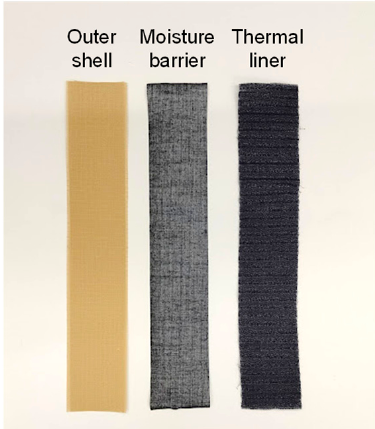
Figure 1. Example of firefighters’ protective clothing fabrics (Sample A).